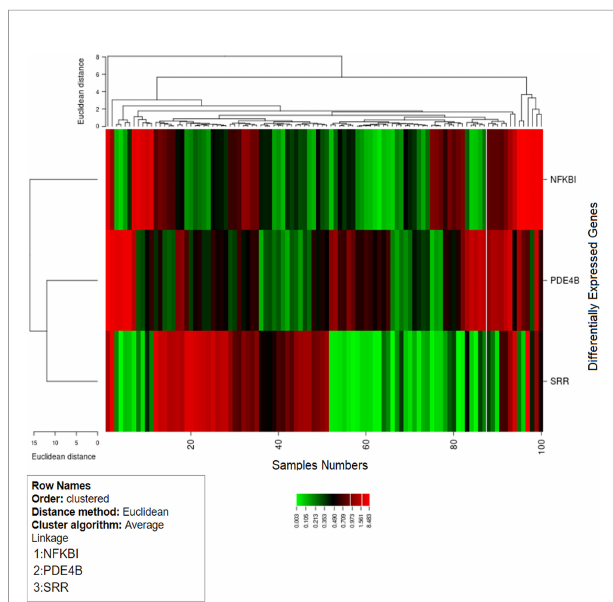
FIGURE 8 | Hierarchical cluster analysis heat map indicates the expression pro fi les of differentially expressed genes ( SRR , NFKB1 , and PDE4B ). The columns in the fi gure represent the sample numbers and the rows represent the differentially expressed